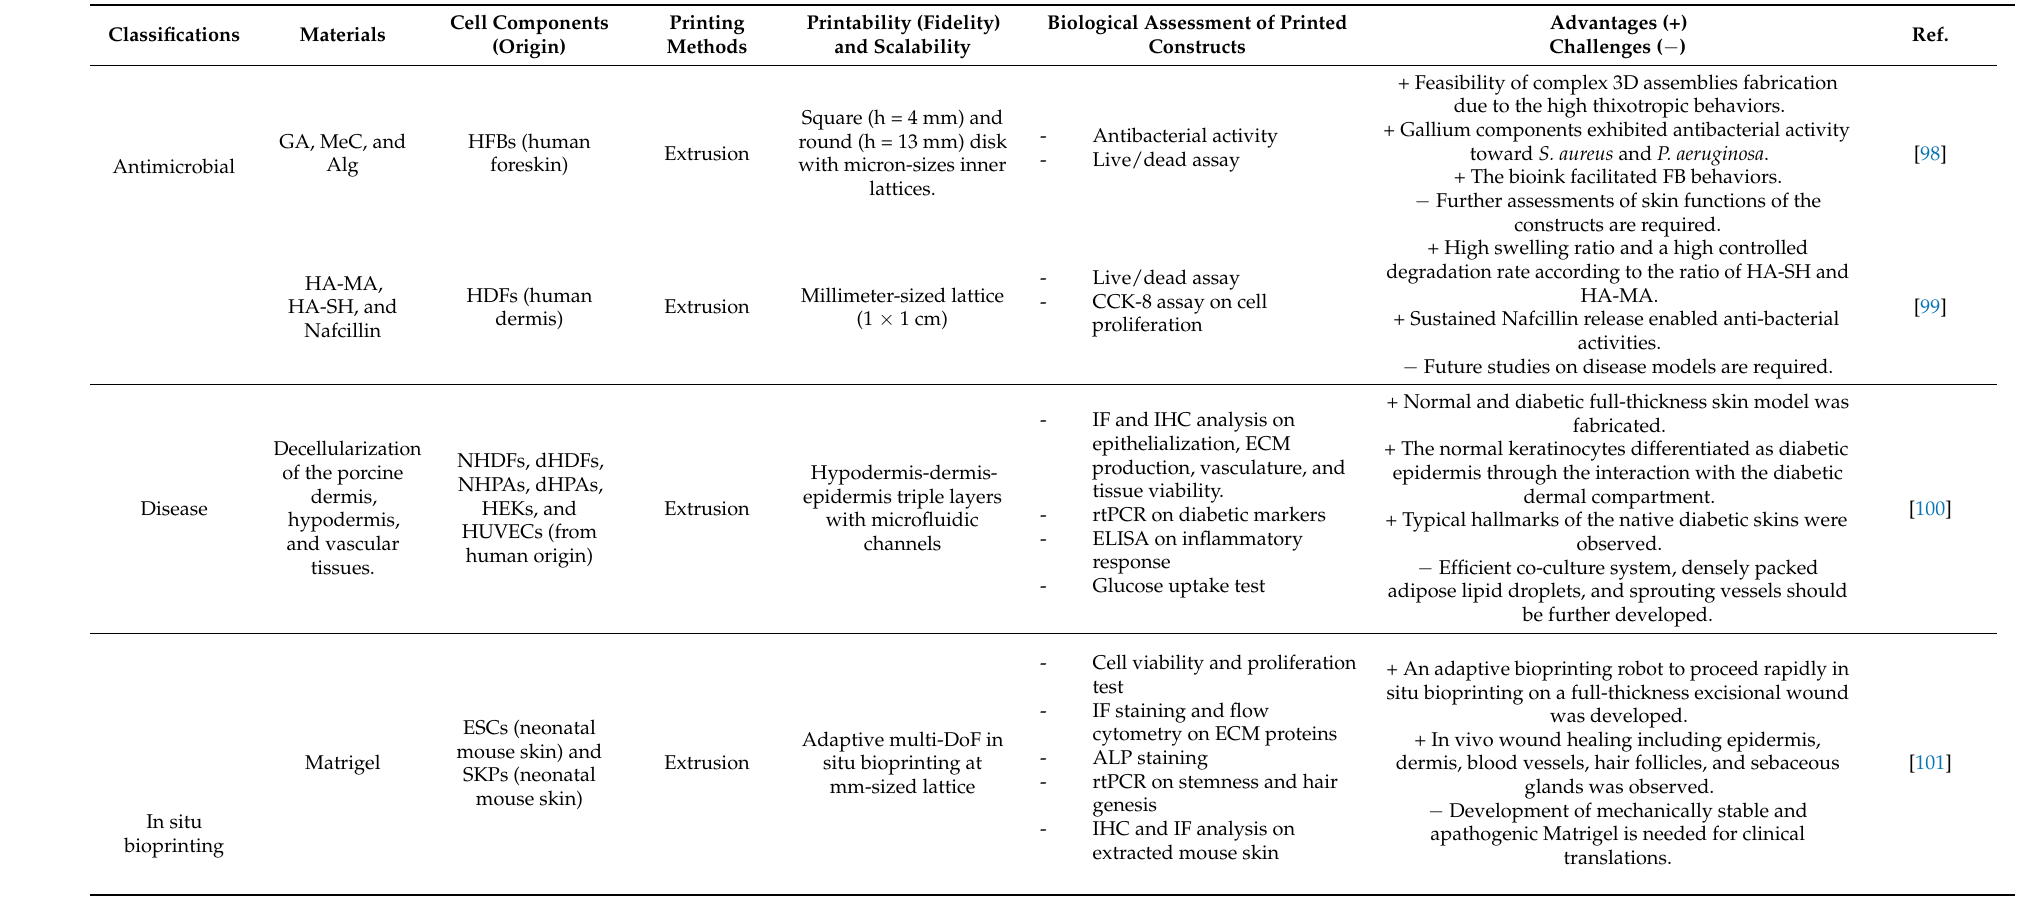
Table 3. Functional Advances in 3D Bioprinting